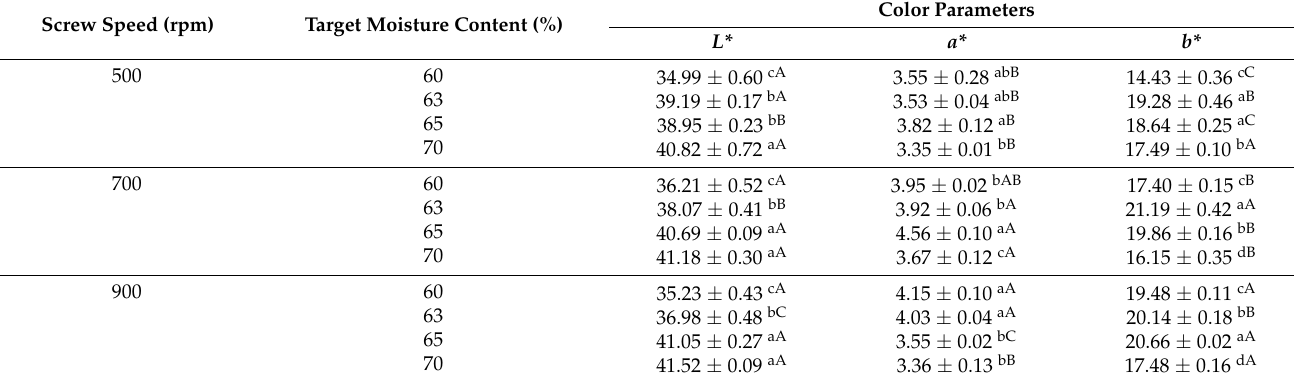
Table 8. Result of L* , a*, and b* of extrudates from mixed proteins (RPC:YPI) at different screw speeds and target moisture contents. Screw Speed (rpm)